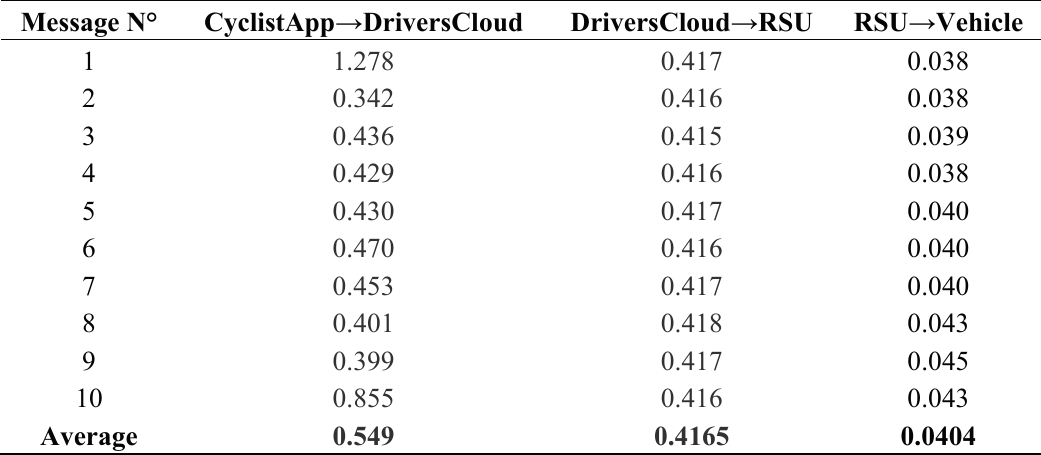
Table 4. Delay measurements in a real scenario